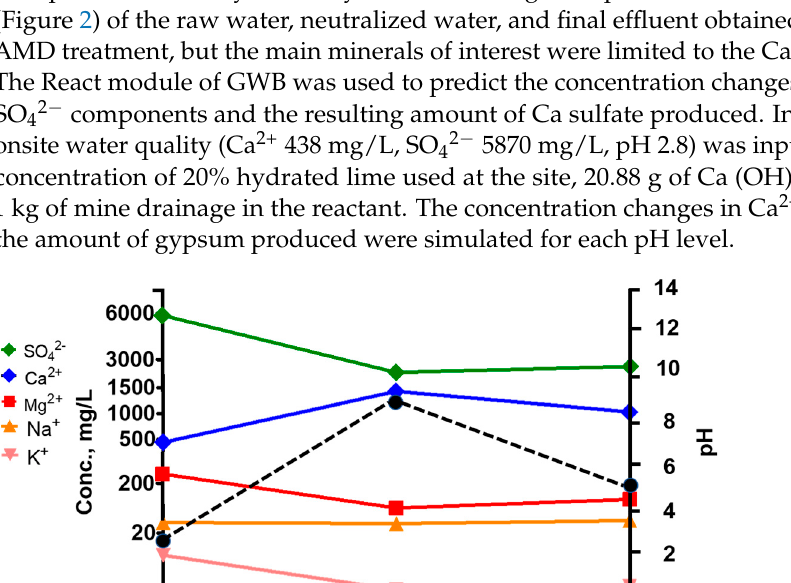
Figure 1. Sampling points (( a , b ) and ( c )) in the AMD treatment facility.